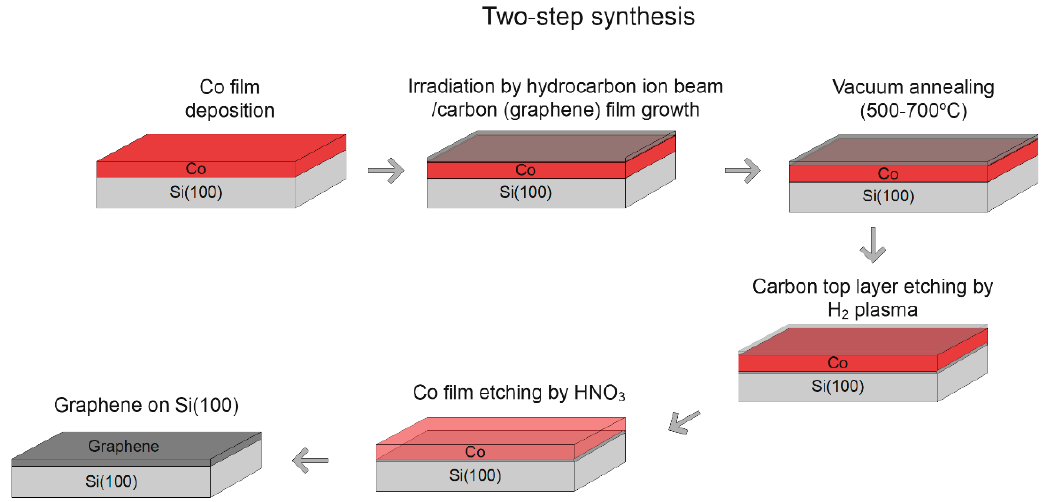
Figure 2. The diagram of a direct cobalt-assisted two-step ion beam synthesis. Table 1. Varied parameters of direct single and two ‐ step graphene synthesis in the present study.